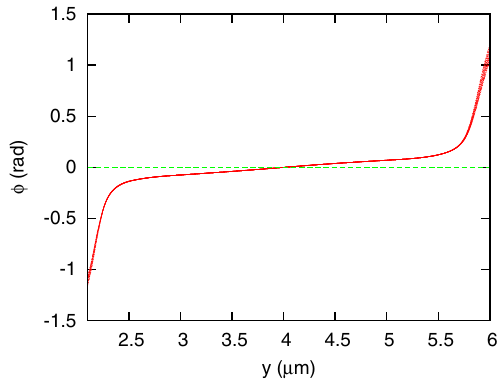
FIG. 3. The final kinetic energy distribution (at instant 21 T of accelerated protons versus the transversal position y .